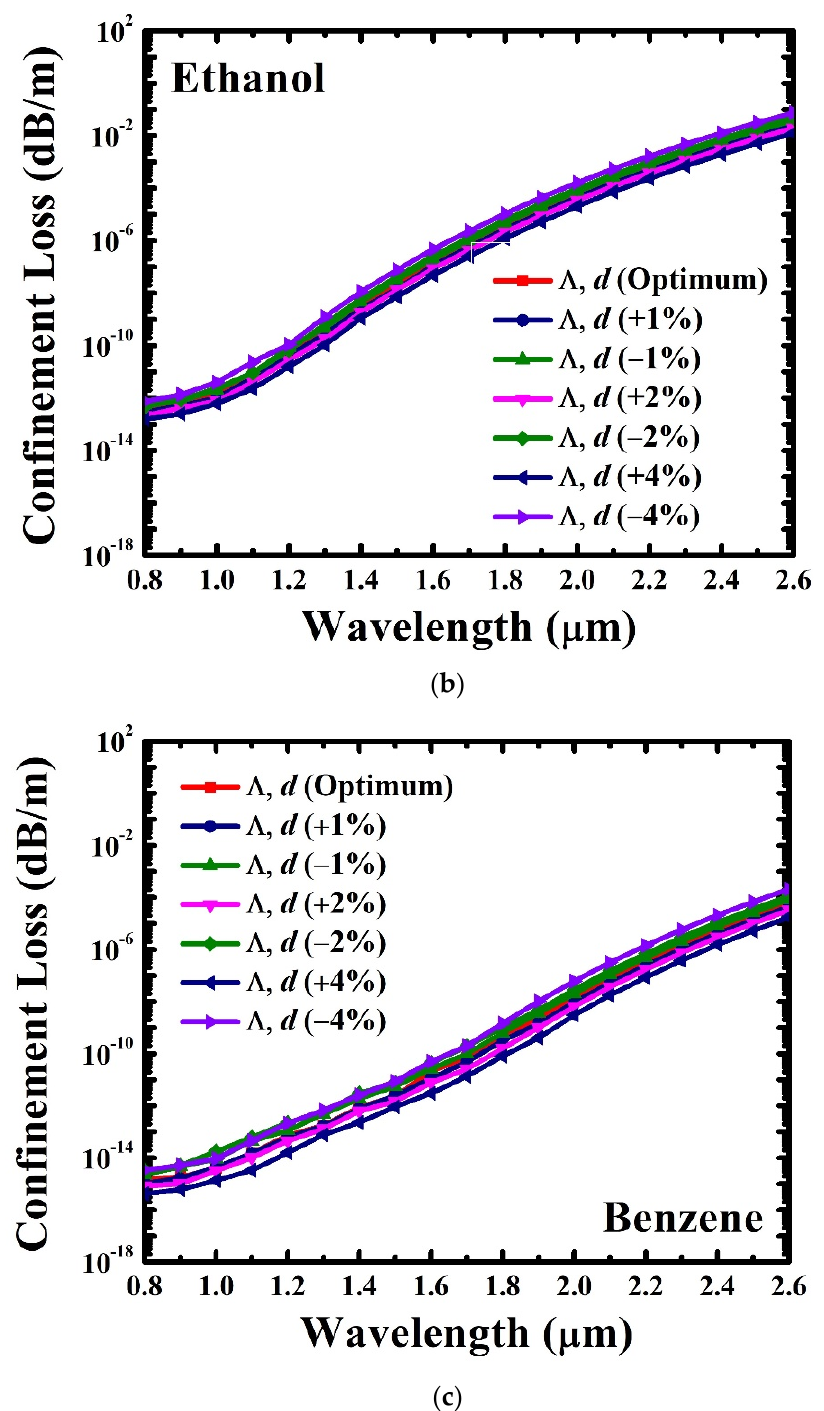
Figure 10. ( a ) Tolerance analysis of confinement loss for water in the variations of ±1%, ±2% and ±4%. ( b ) Tolerance analysis of confinement loss for ethanol in the variations of ±1%, ±2% and ±4%. ( c ) Tolerance analysis of confinement loss for benzene in the variations of ±1%, ±2% and ±4%.